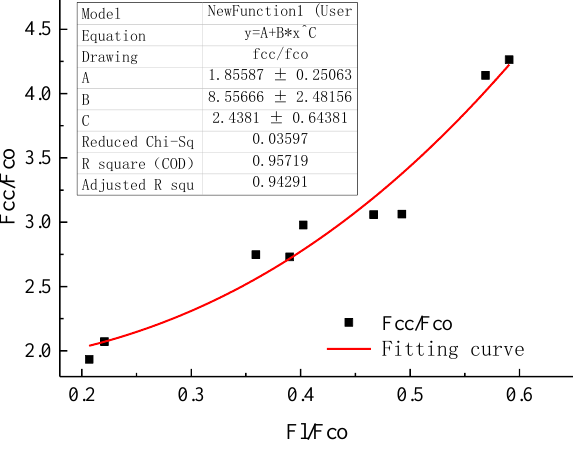
Figure 7. Model fitting result. “*” Represents a multiplication symbol.